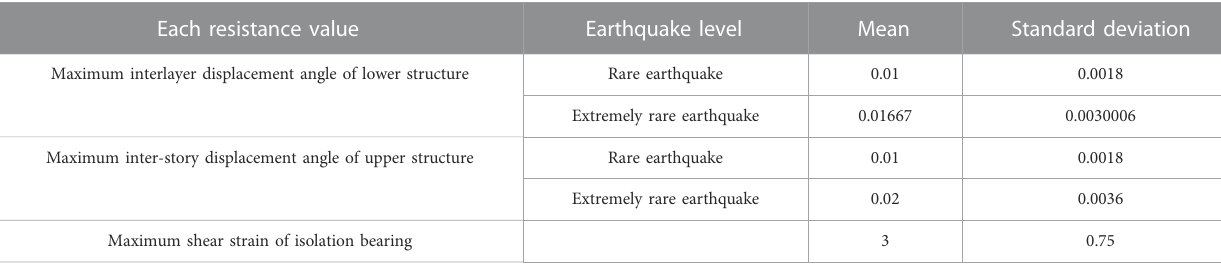
TABLE 2 Probabilistic characteristic parameters of structural limiting